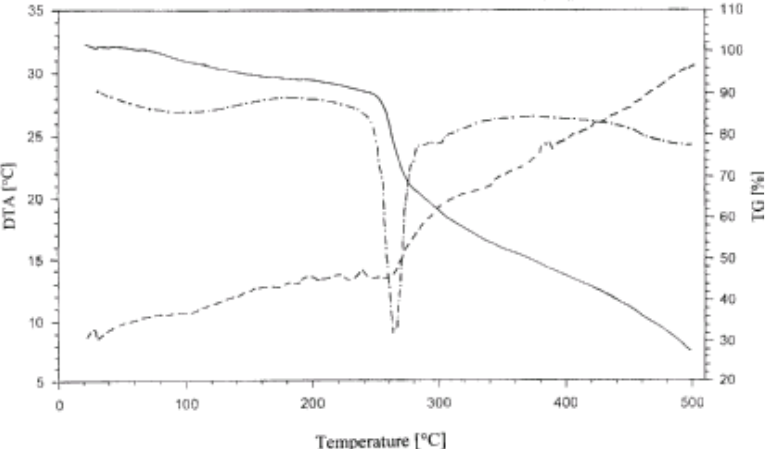
Figure 7. Thermogram (TG, DTG, DTA) of casein/GPCS 1:2 complex in the 25-500 o C